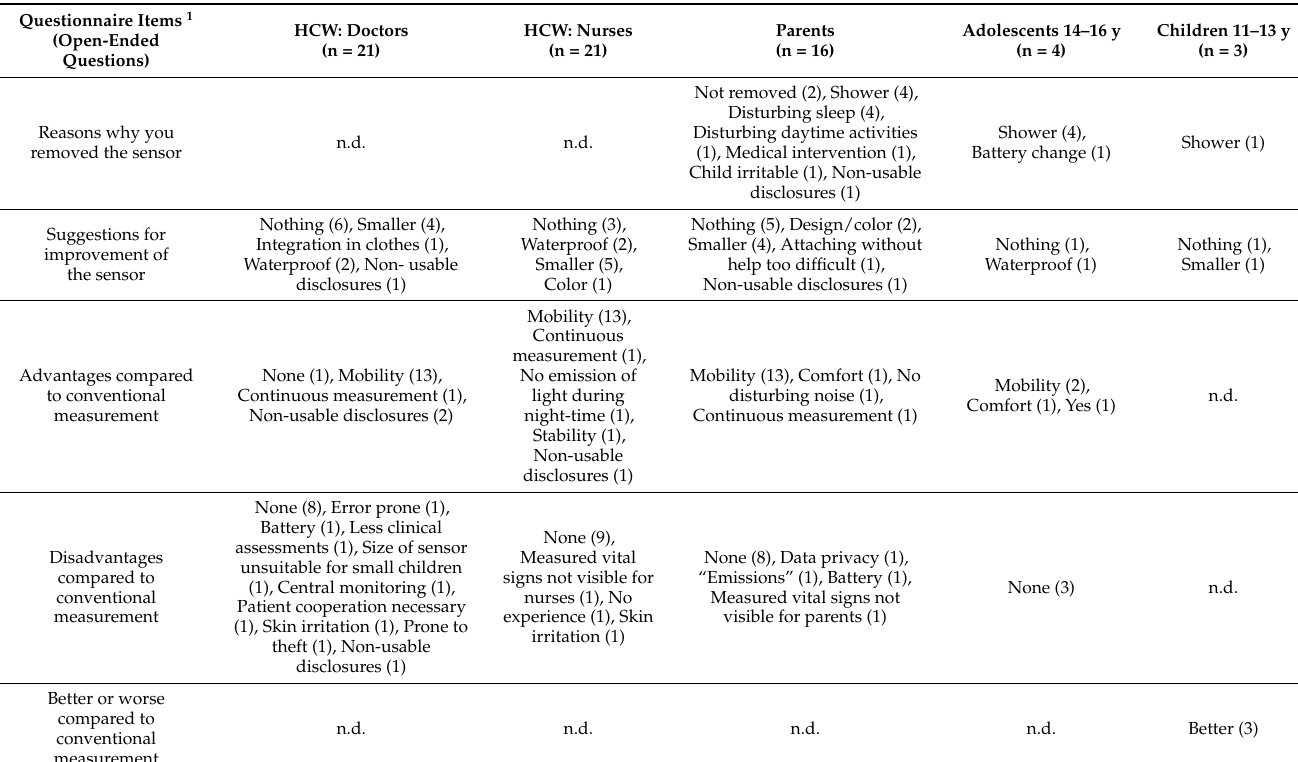
Table 2. Themes endorsed by health-care workers, parents, and children on open-ended feasibility